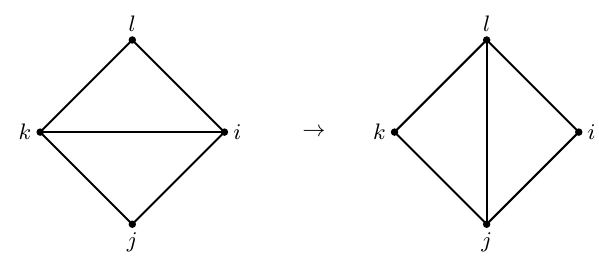
Figure 16. A visual representation of the plucker relations for Gr (2 , n ) .